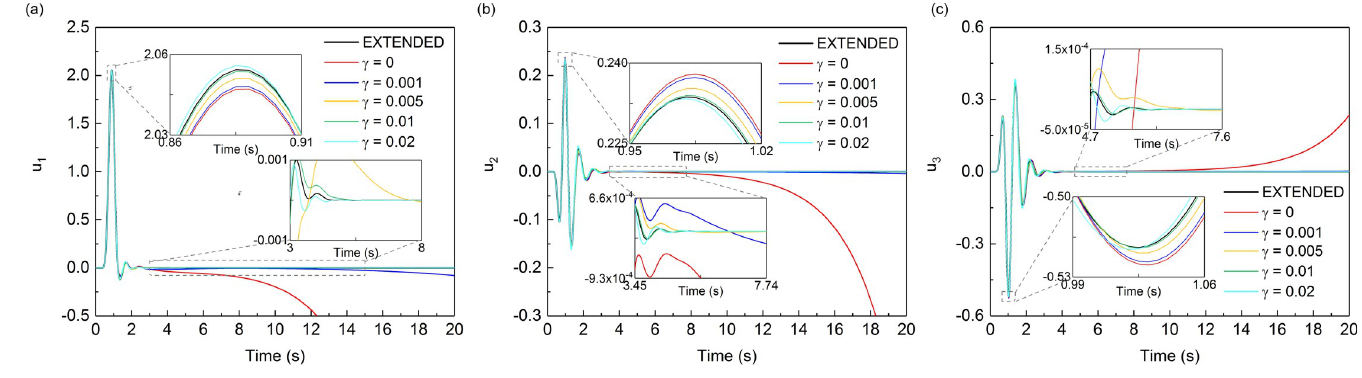
Fig 11. Displacement time-histories of observation point B